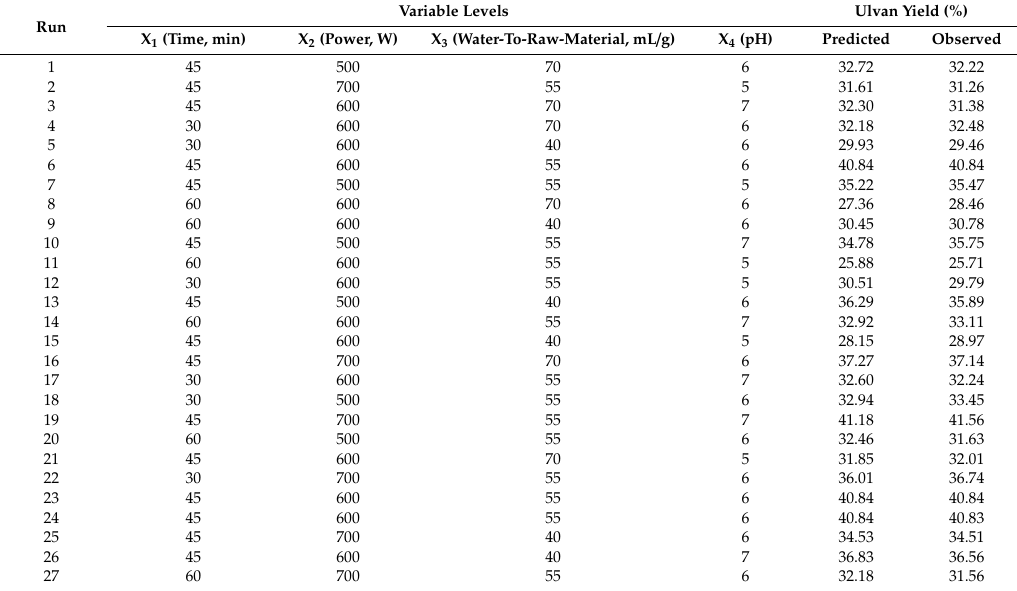
Table 1. Box–Behnken (BBD) matrix of the four variables, levels for response surface methodology (RSM), experimental data, and predicted values of ulvan